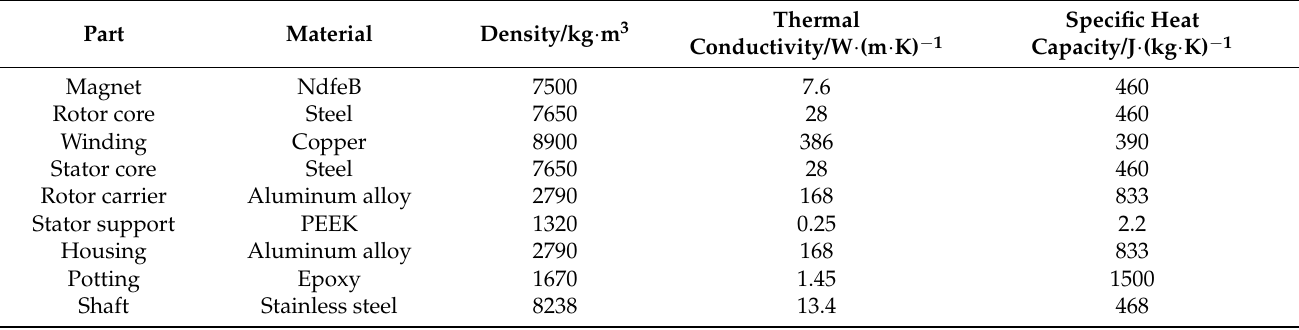
Table 6. Material properties of the motor